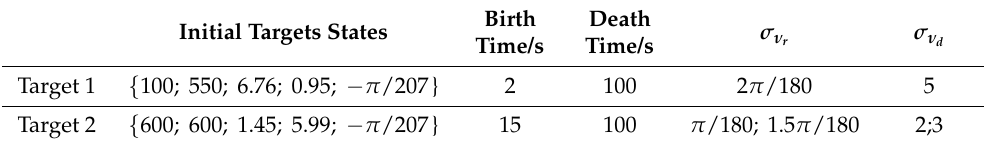
Table 2. The information of true